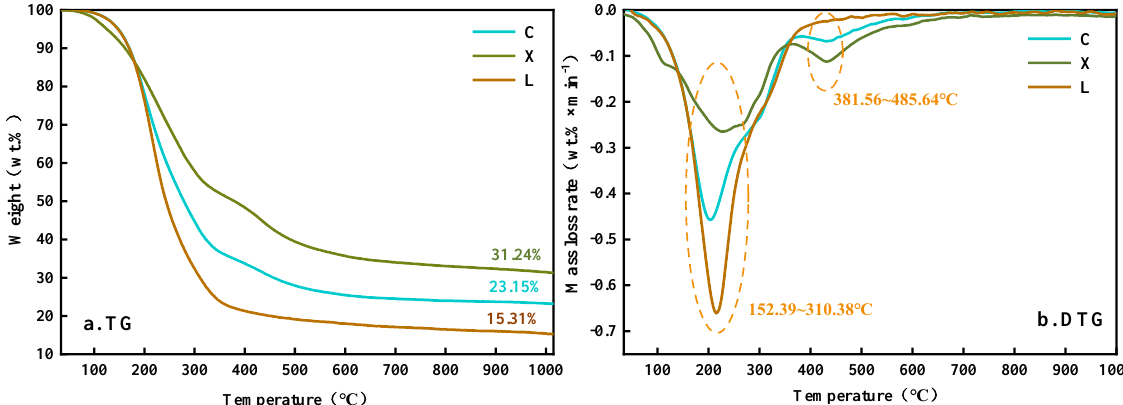
Figure 1. TG − DTG of different single-component hydro-thermal bio-oils .